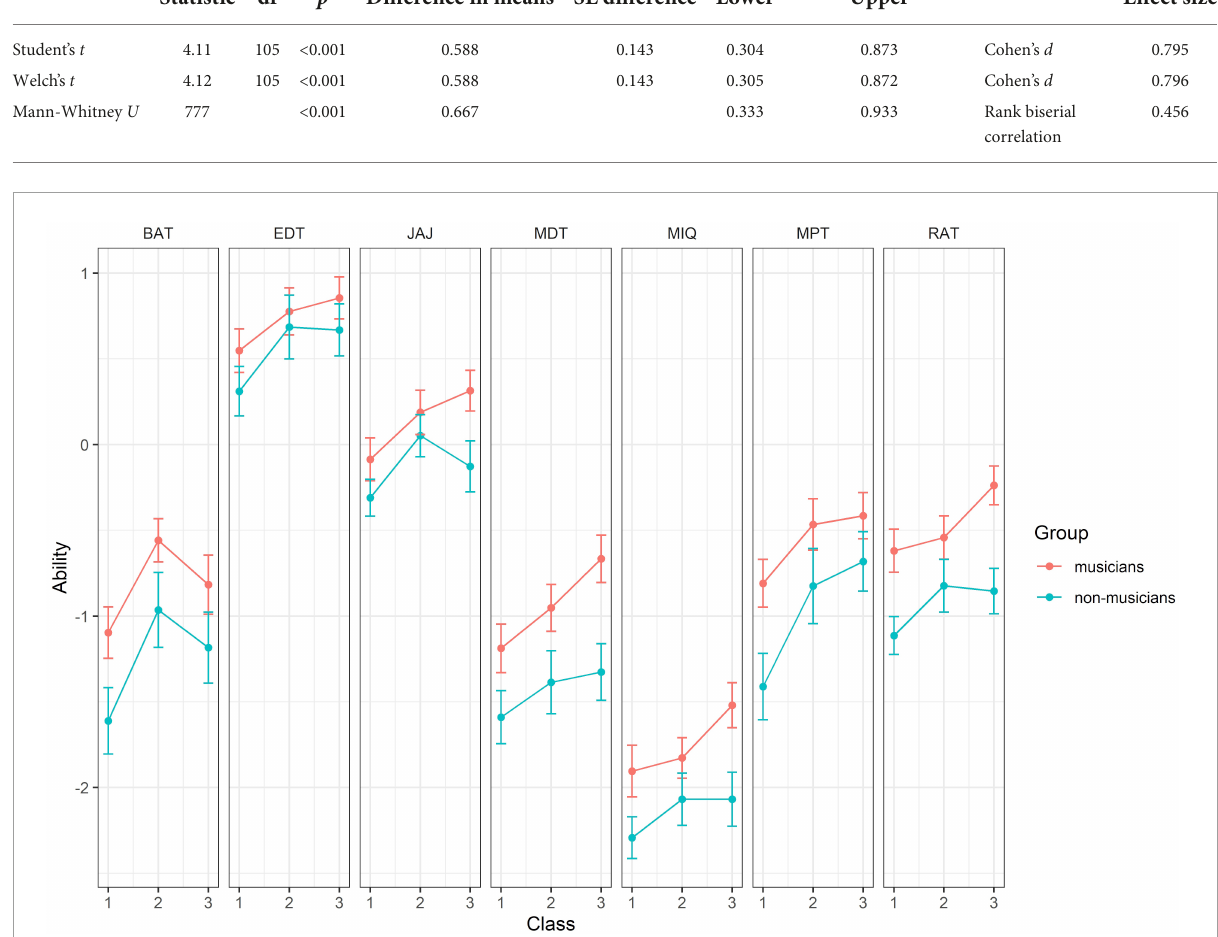
FIGURE1 Mean ability values for the seven performance tests by grade and quasi-experimental group. Error bars indicate standard error of mean. BAT, Beat Alignment Test; EDT, Emotion Discrimination Test; JAJ, Jack&Jill Working Memory Test; MDT, Melody Discrimination Test; MIQ, matrix reasoning; MPT, Mistuning Perception Test; RAT, Rhythm Ability